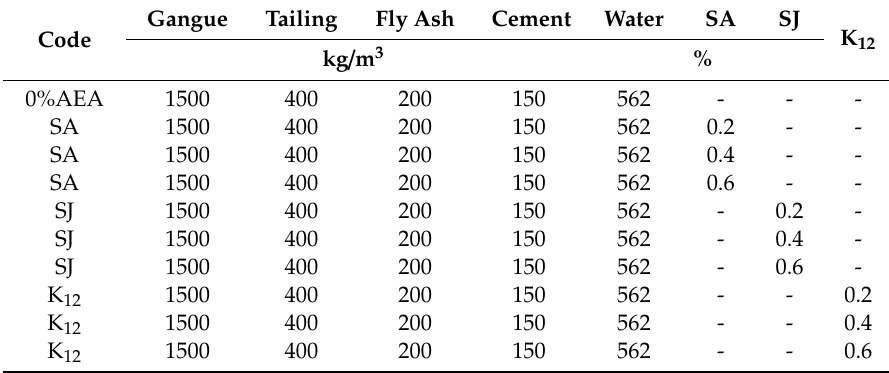
Table 4. Details of mixture proportions for the cemented paste